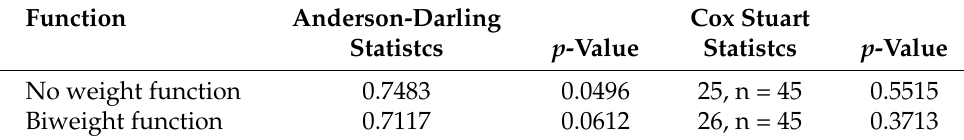
Figure 5. ( a ) Pearson residuals plot and ( b ) Normal Q-Q plot of the Pearson residuals for the Model VI based on biweight function as mentioned in Table 6. Table 7. Anderson-Darling and Cox Stuart test for Pearson residuals of the Model VI.